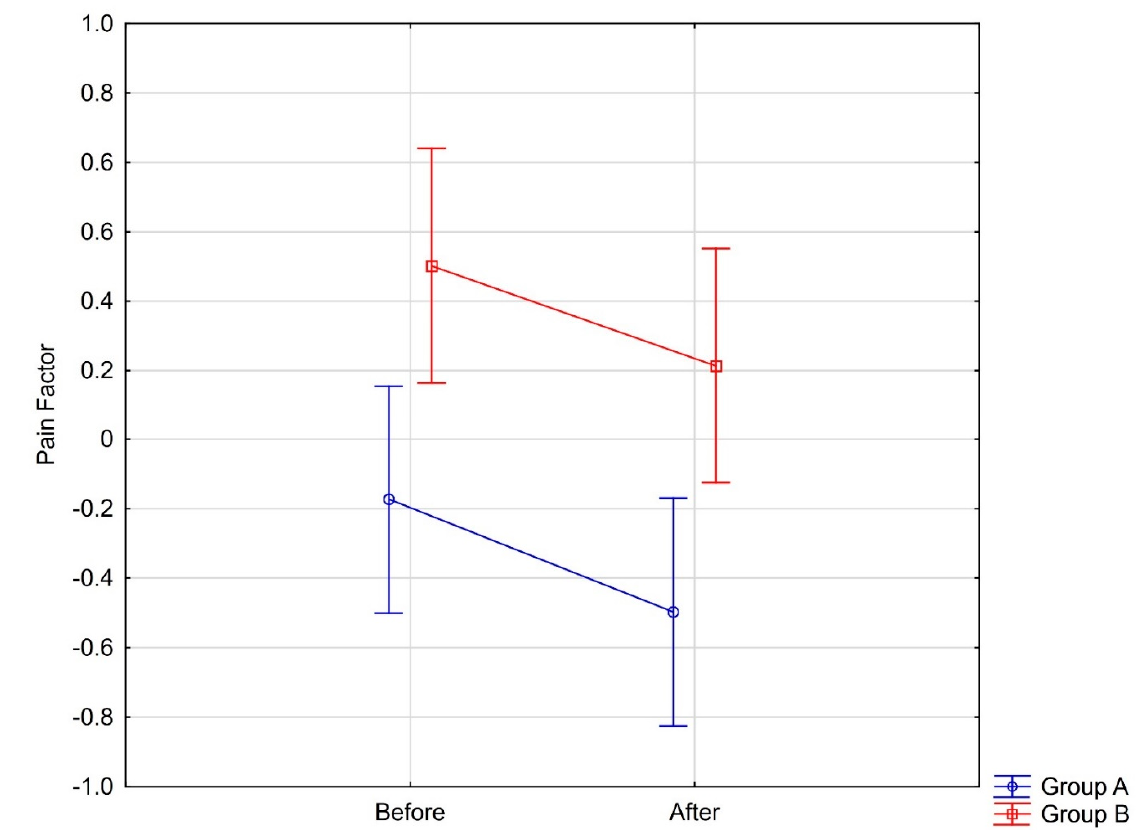
Table 2. Loadings of variables used to component interpretation.